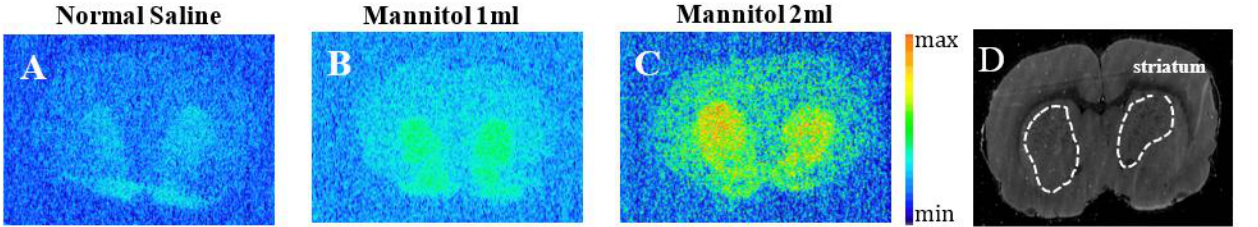
Figure 4. Representative ex vivo autoradiography of [ 99m Tc]Tc TRODAT-1 coronal sections of brain DAT uptake in 2 mL of normal saline ( A ), 1 mL ( B ), and 2 mL ( C ) of 20% mannitol pre-treated rats and ( D ), the corresponding striatal digital image. The averaged specific binding ratios in the 3 groups were 0.21 ± 0.03, 0.91 ± 0.29, and 1.76 ± 0.52, respectively ( p < 0.05 compared to the adjacent group).